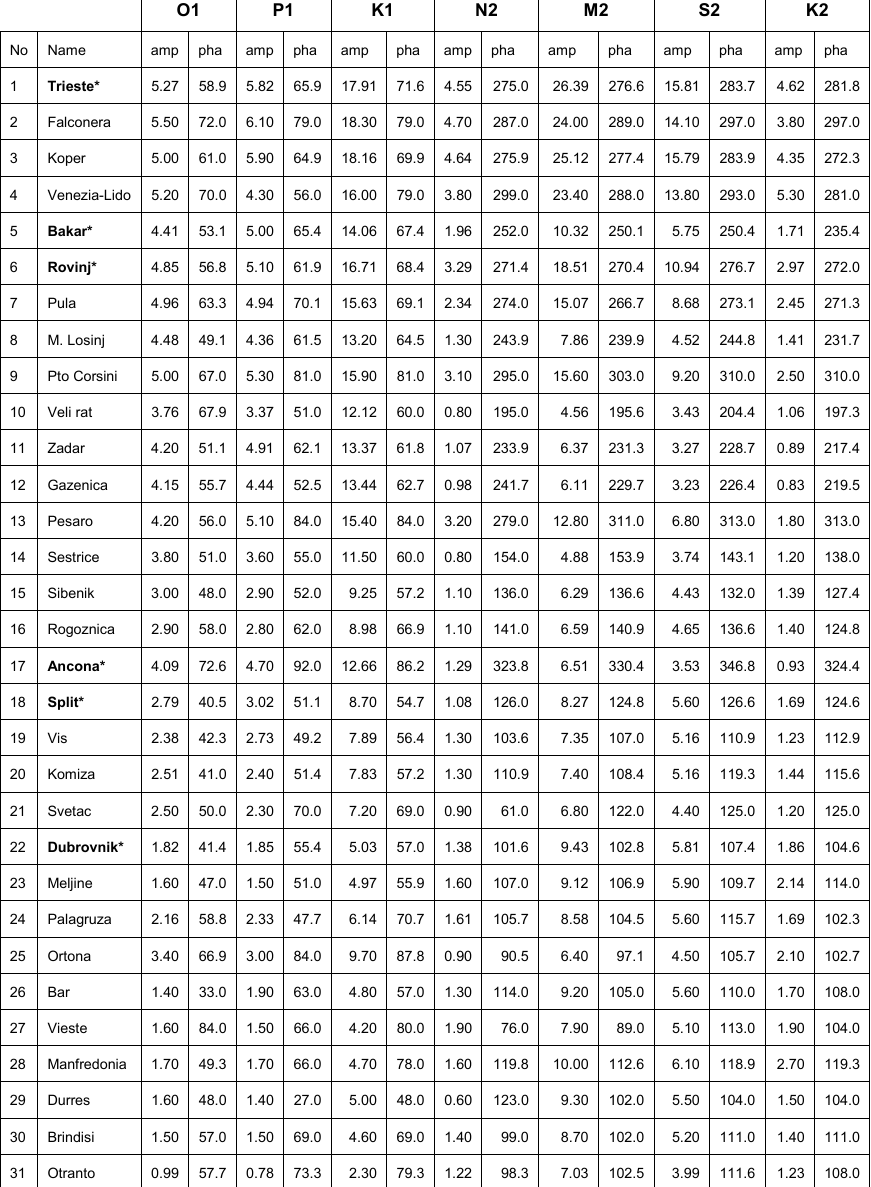
Table 1. Tide-gauge stations with harmonic constant values used in the study; bold names with the asterisk mark the stations for which we calculated the constants. Amplitudes are in cm and phases are degrees relative to 15E. O1